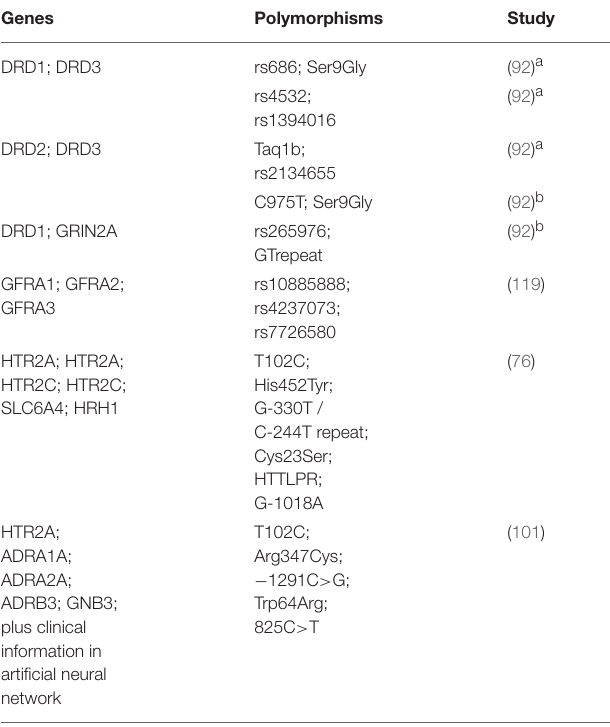
TABLE 11 | Significant gene-gene interaction results.